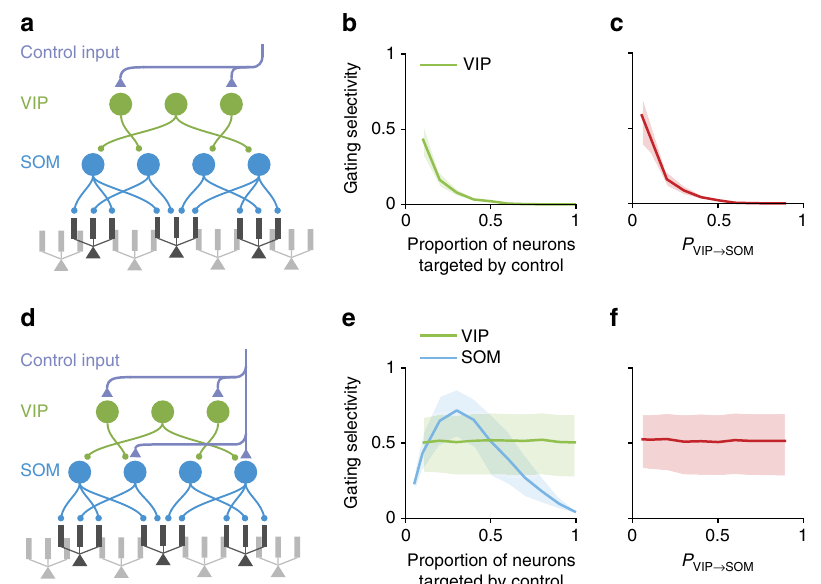
Figure 5 | Two possible schemes of control for the interneuronal circuit. We built a simplified circuit model containing VIP, SOM and pyramidal neurons. ( a – c ) Control signals target only VIP neurons. ( a ) In this scheme, for each pathway, control inputs target a random subset of VIP neurons. And the connection probability from VIP to SOM neurons is P VIP - SOM . ( b , c ) Good gating selectivity is only achieved when a small subset of VIP neurons is targeted by control inputs ( b ), and when the VIP–SOM connections are sparse ( c ). ( d – f ) Control signals target both VIP and SOM neurons. ( d ) In this scheme, we assume that for each pathway control inputs target a random subset of VIP and SOM neurons. ( e ) Gating selectivity depends on the proportion of SOM (blue) but not VIP (green) neurons targeted by control input. ( f ) Gating selectivity does not depend on P VIP - SOM . Curves and shaded regions are as in Fig. 4.